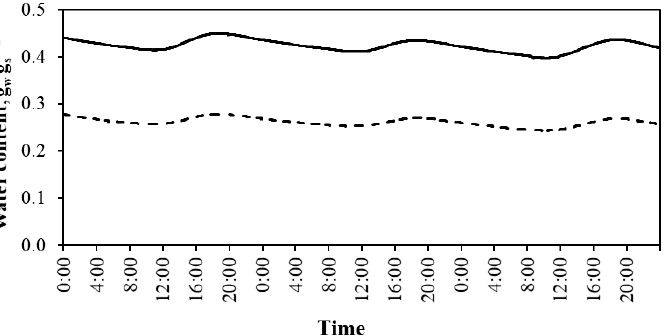
Figure 5. Soil water content (water mass g w /soil mass g s ), measured at 0.20 m depth, from the 3 to 5 March 2015: without low tunnel (—); with low tunnel